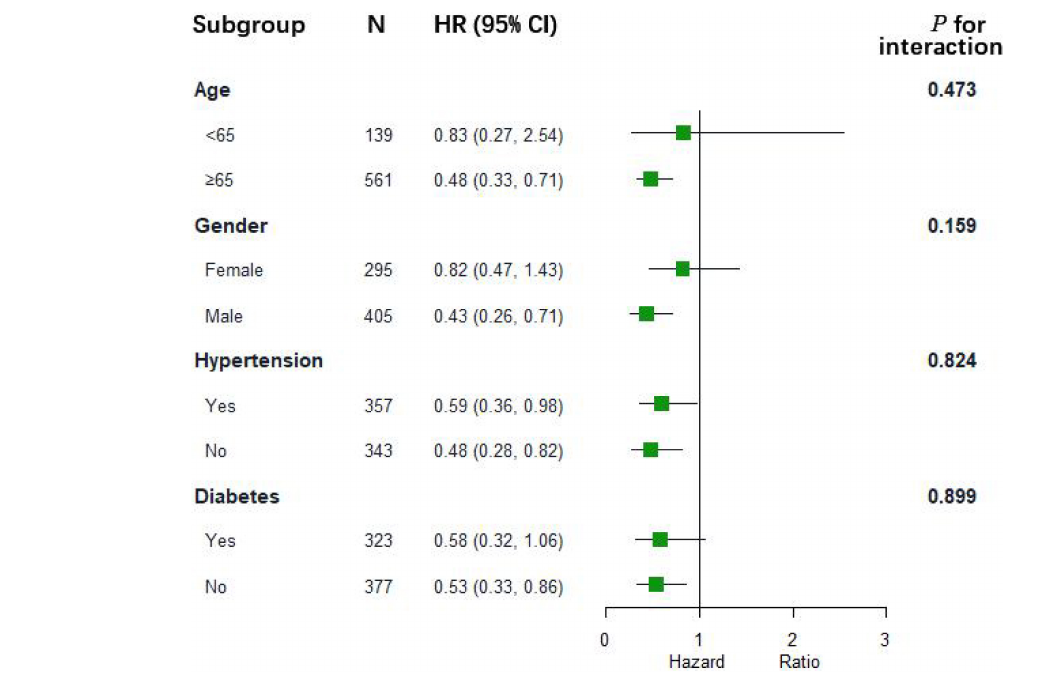
FIGURE2 The association between albumin infusion and 28-day mortality in subgroups. HR hazard ratio; and CI confidence